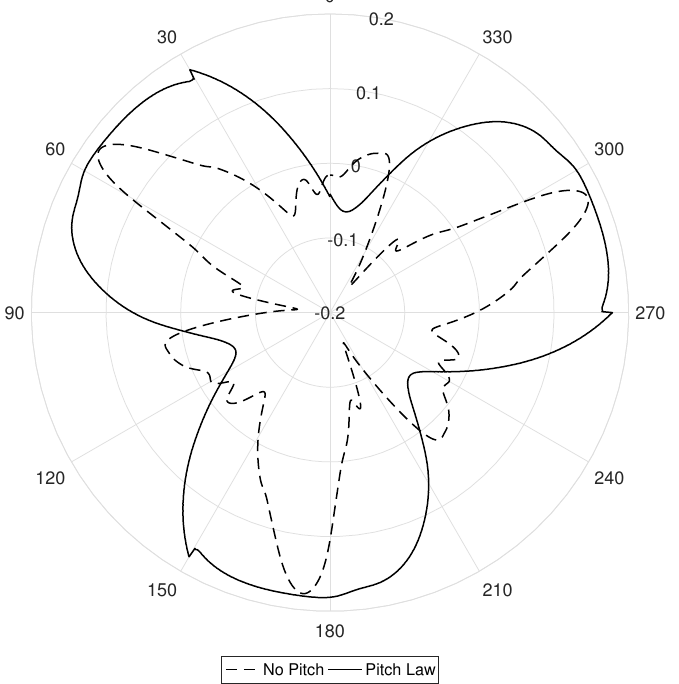
Figure 17. Torque coefficient versus azimuthal position: case without pitch law ( C Mmedium = − 0.16) and with pitch law ( C Mmedium = +